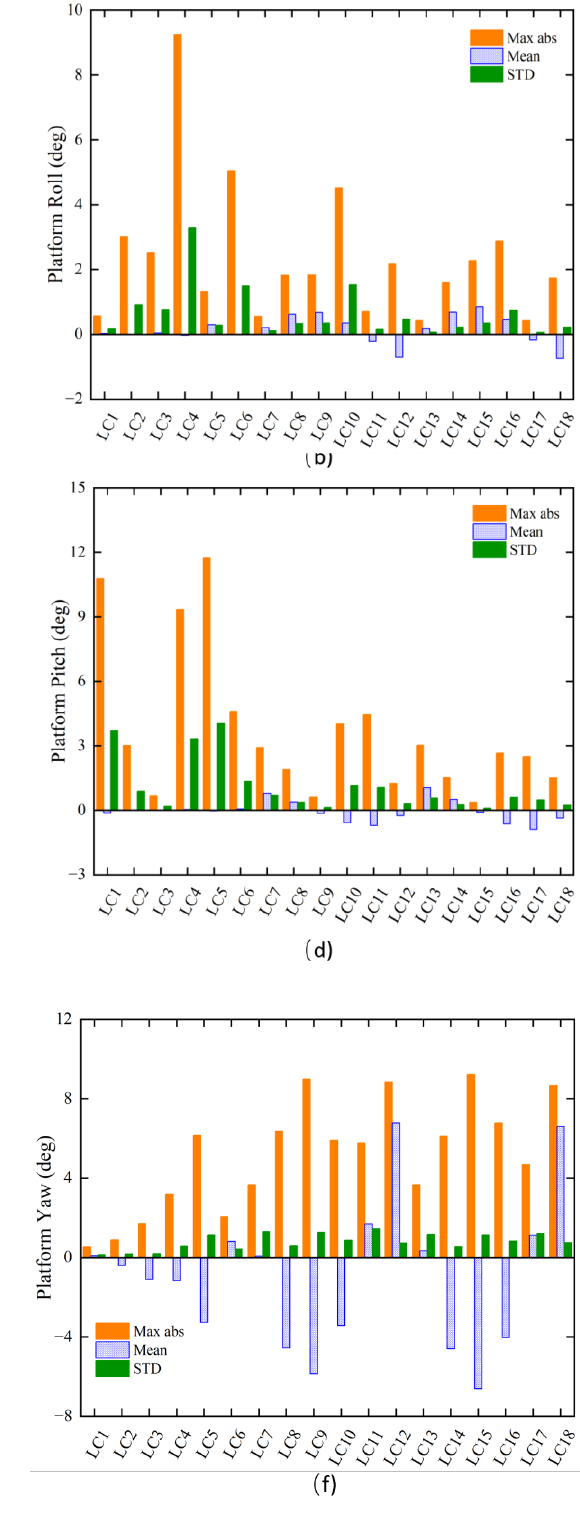
Figure 13. Statistics of the platform motion response for ( a ) surge, ( b ) roll, ( c ) sway, ( d ) pitch, ( e ) heave, and ( f ) yaw for all the considered load cases.